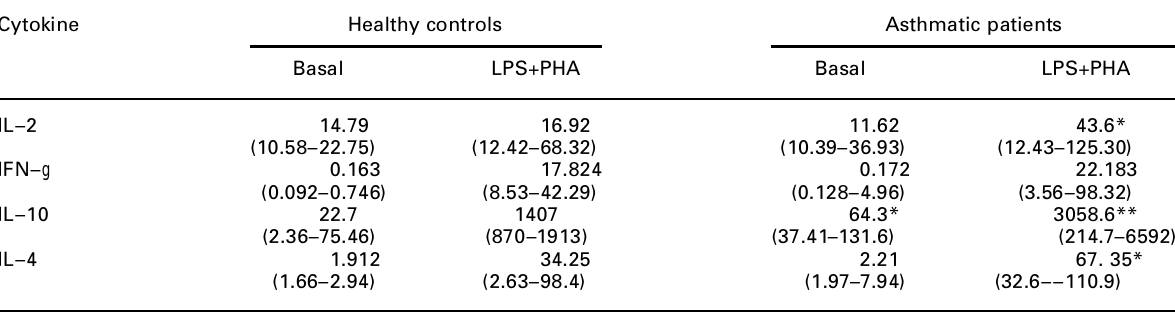
Table 1. IL–2, IFN– g , IL–4 and IL–10 cytokine production by sputum T-cells from asthmatic patients and healthy controls Cytokine